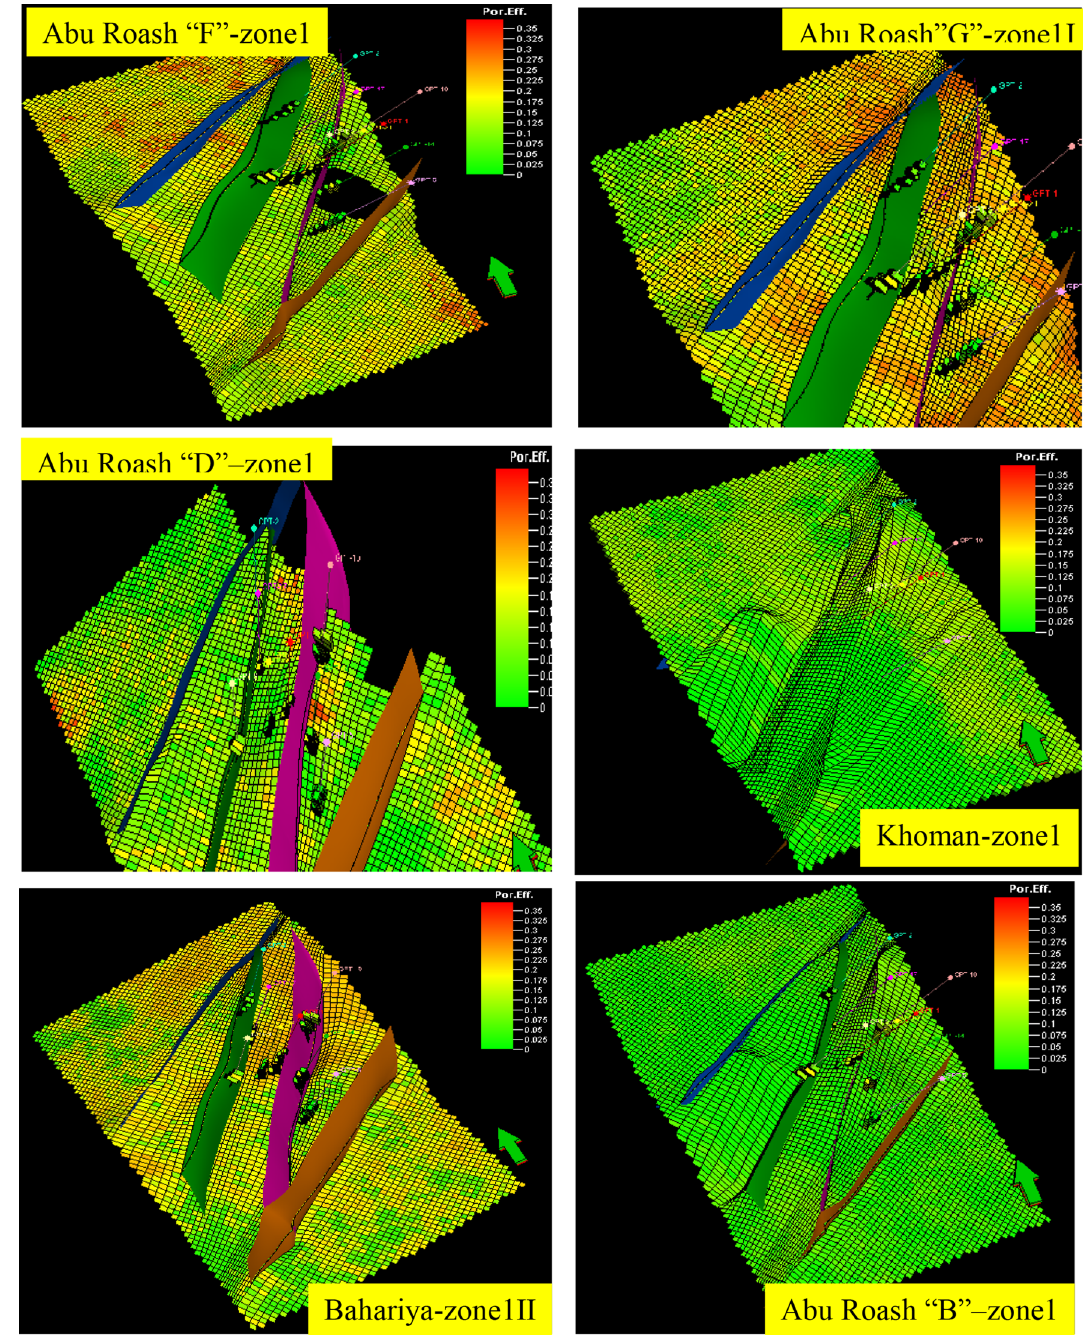
Fig. 16 Effective porosity model example for the some pay